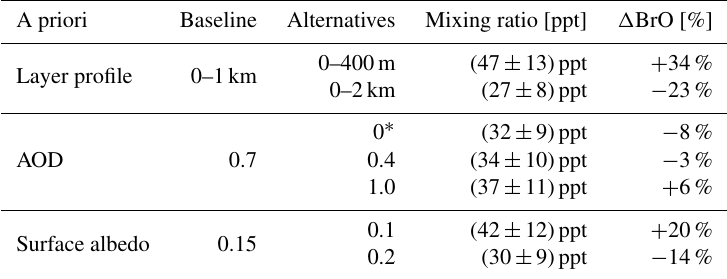
Table 1. Uncertainty of BrO mixing ratio estimation based on the variation of assumed properties (BrO profile, surface albedo, aerosol optical density) for the AMF